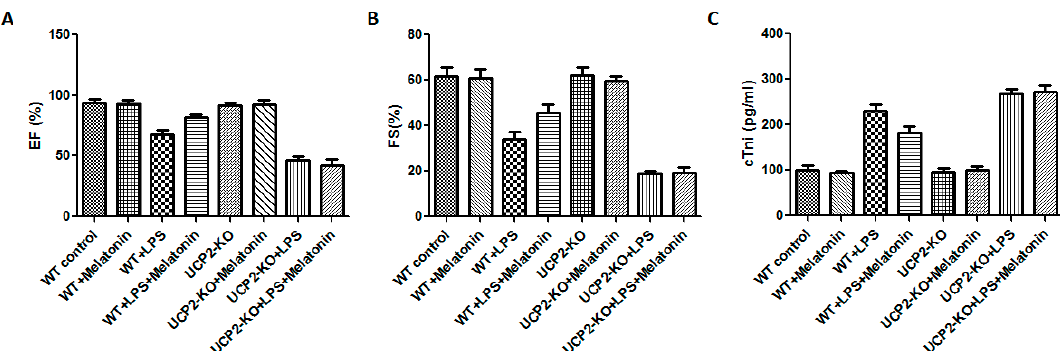
Figure 1. Effect on ejection fraction (EF) and fractional shortening (FS) and tissue injury (troponin, cTnl). EF (Panel ( A )), FS (Panel ( B )), and cTnl (Panel ( C )) were assessed in the animals following injection of LPS and/or melatonin as described in the methods. Vertical axes: Percentage of EF (Panel ( A )) or FS (Panel ( B )), or level of cTnl (pg/mL, Panel ( C )). Horizontal axes: Groups of animals.